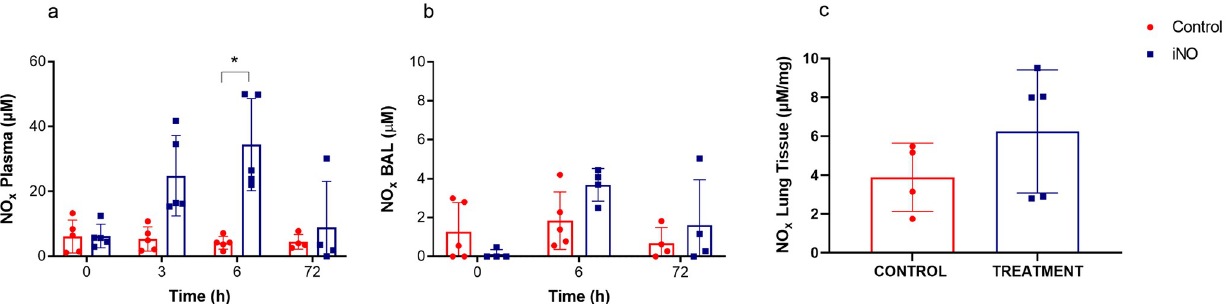
Fig 5. Nitric oxide byproducts formation (NO x ) overtime in control versus iNO treated animals. The uptake of iNO was estimated by monitoring NO x concentrations in plasma, BAL and lung tissue. NO x levels were measured using modified Griess method in combination with Griess reagent system. (a) NO x gradually increased in plasma over time and was significantly higher in the iNO group (blue, n = 5) at 6h when compared to control (red, n = 5) p = 0 . 032 , consistent with iNO delivery. After 72 hours, levels were back to normal and comparable to controls. We did not notice any significant differences in NO x levels in BAL (b) and lung tissue (c). Graphs represented through interleaved scatter with bars with individual values plotted as mean with standard error of mean. � = statistically significant. Definition of abbreviation: BAL = bronchoalveolar lavage, iNO = inhaled nitric oxide, and NO x = nitric oxide